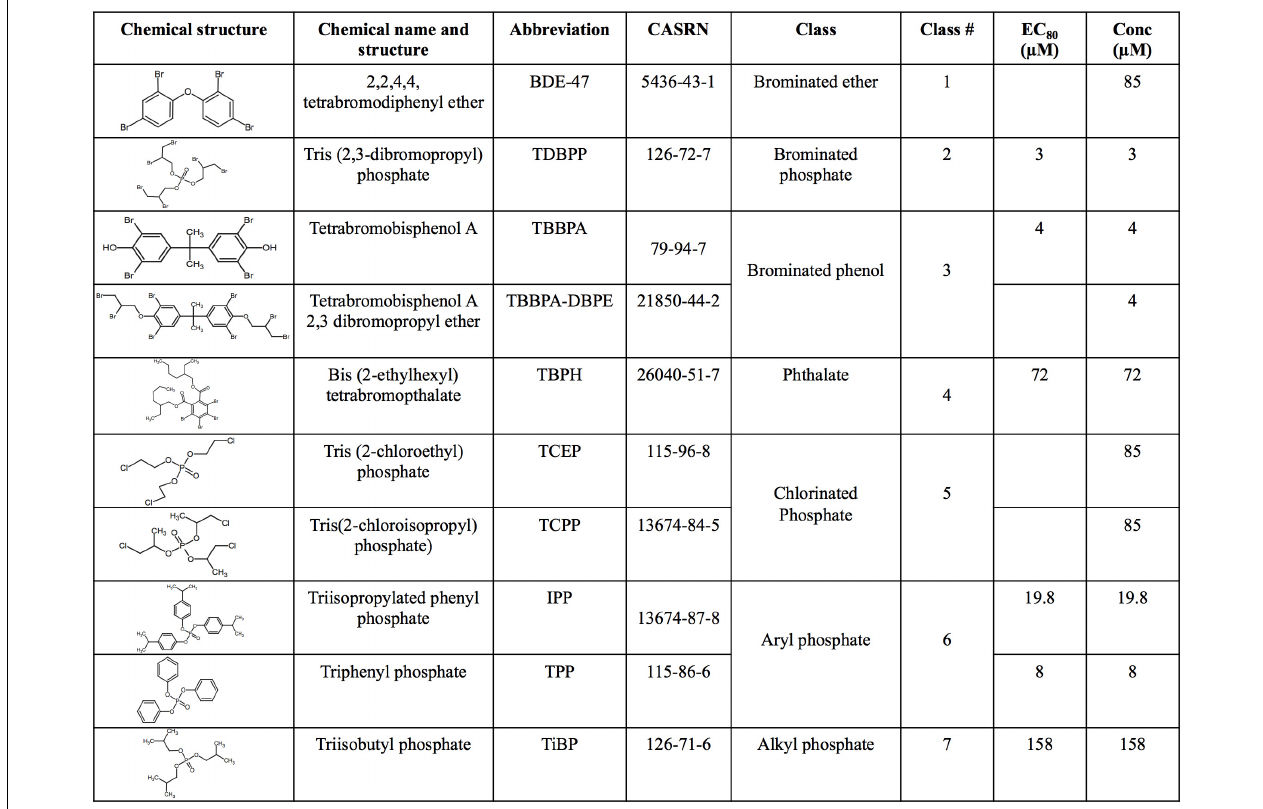
FIGURE 1 | Chemical name, structure, abbreviation, CAS number, physicochemical classes, EC 80 s and exposure concentrations (“Conc”) of flame retardant chemicals (FRCs) used in this study. “Conc” represents concentration used for exposures in the study. For FRCs, EC 80 s [exposure concentrations demonstrating 80% morphological effects based on Truong et al. (2020)] were used as exposure concentrations, except BDE-47, TCEP and TCPP where limit concentration (85 µ M) or TBBPA-DBPE where a TBBPA-matched concentration (4 µ M) was